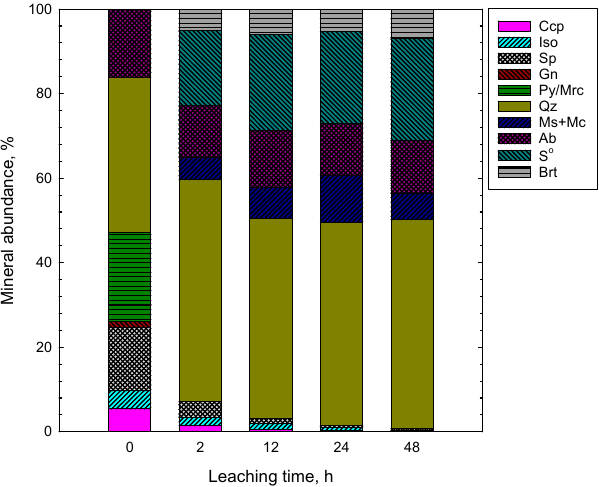
Figure 5. Mineral distribution (semi-quantitative XRD) in the feed (0) and leaching residues (1 M H 2 SO 4 , 1 M NaCl, 80 °C, 67% PN, 33% SMS). Abbreviations after [23]: Ccp—chalcopyrite, Sp—